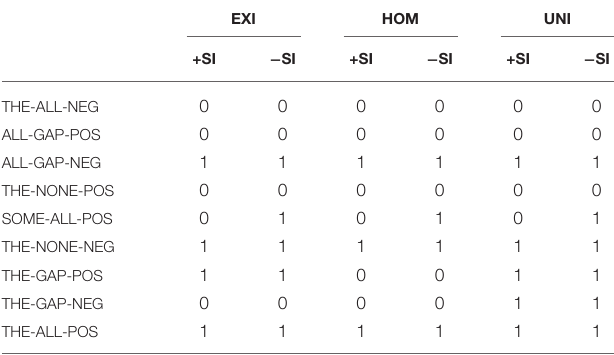
FIGURE 7 | Within-subject mean responses on affirmative homogeneity and implicature items for children in Experiment 1 (recall that rejection (0) on the task corresponded to + homogeneous and + implicature responses).